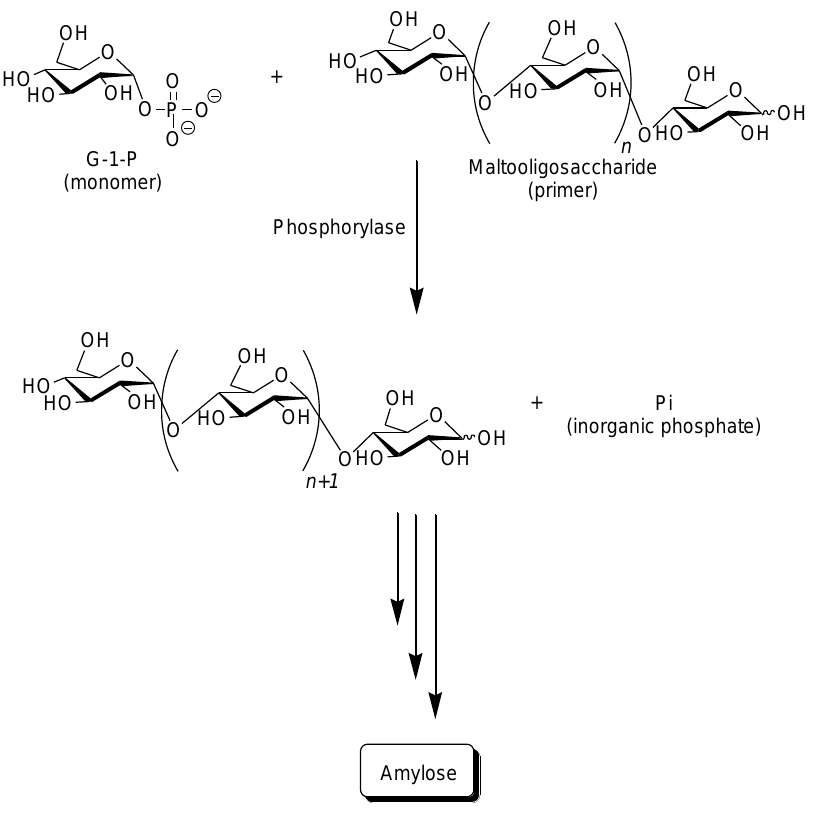
Figure 3. Phosphorylase-catalyzed enzymatic polymerization of G-1-P to form